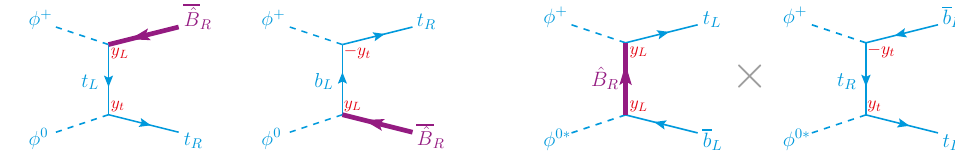
Figure 5 . The diagrams for the 2 → 2 cross sections corresponding to the amplitudes in figure 4 (via the optical theorem). The two diagrams on the left contribute to σ ( φ + φ 0 → ˆ B R t R ) . The two diagrams on the right contribute to σ ( φ + φ 0 ∗ → t L b L ) , but only the interference term is proportional to y 2 y 2 t L